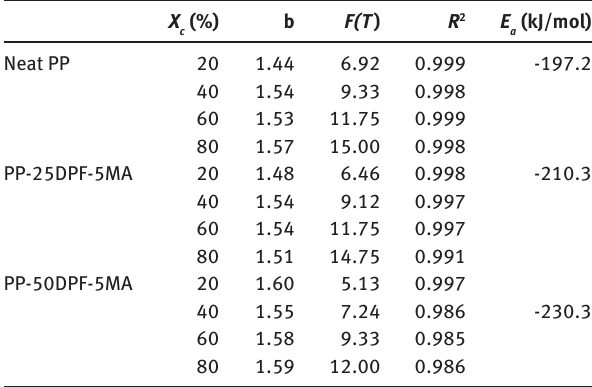
Table 4: Mo’s parameters for neat polypropylene (PP) and PP-DPF composites.